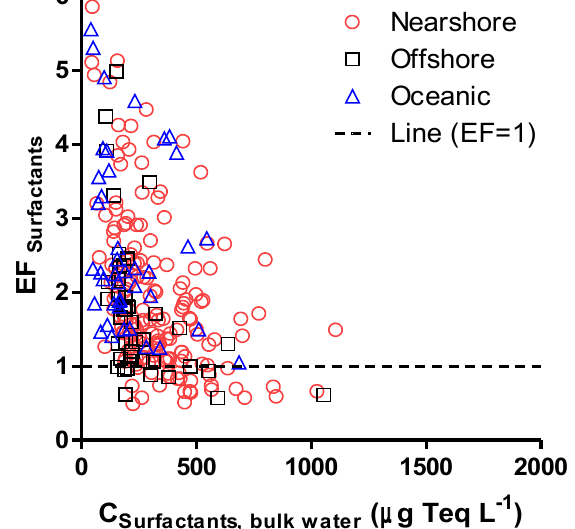
Fig. 5. Diminshing surfactant enrichment factors (EFs) with in- creasing bulk water concentration in nearshore (within 2km of coast), offshore (2–20km from the coast), and open ocean (further than 20km from the coast).